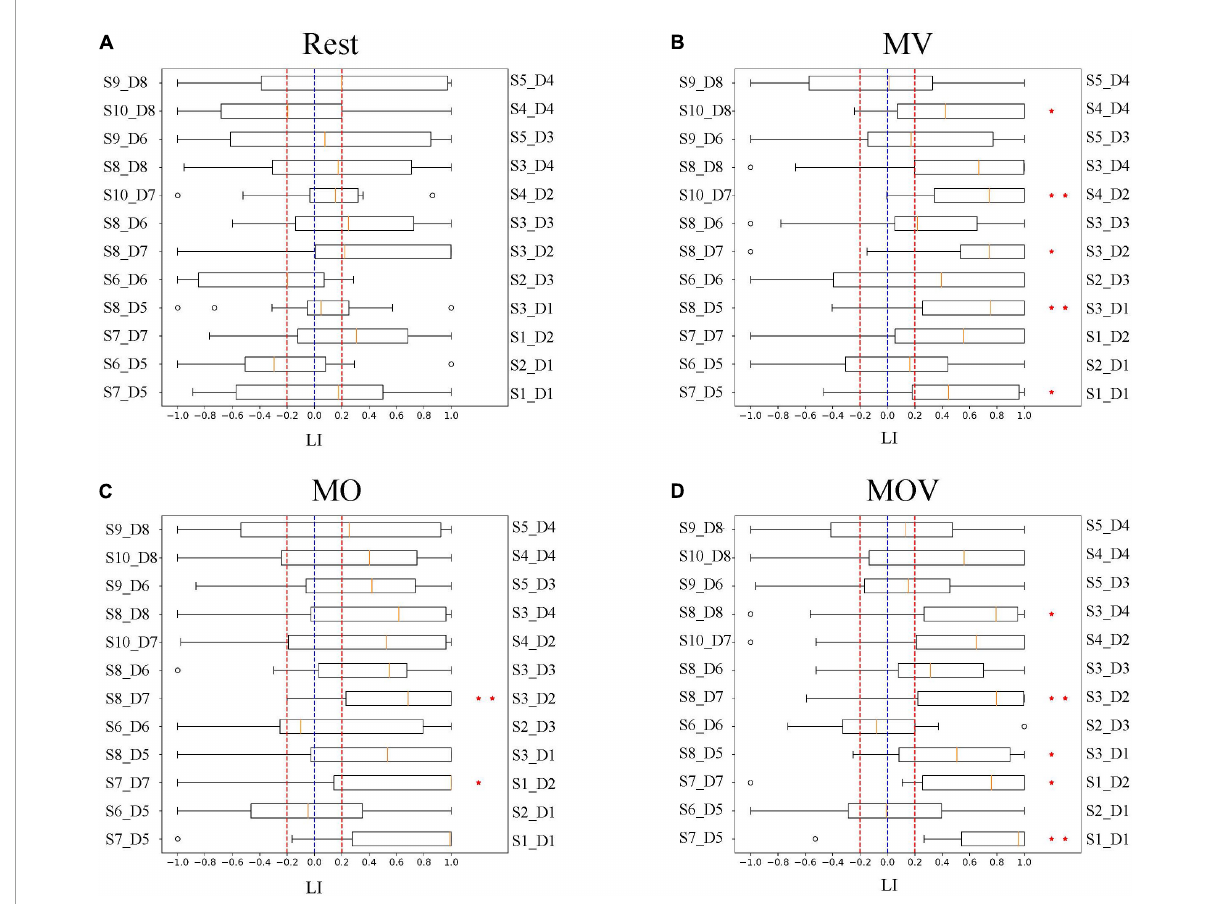
FIGURE8 Cortical lateralization. The subplots (A–D) show the distribution of activation laterality index (LI) for each pair of channel groups under the four task conditions, Rest, MV, MO, and MOV. As shown, the horizontal coordinates of the subplots are the LI, with values ranging from − 1 to 1. The vertical axis indicates the symmetrically located channel groups for 12 channels. Box plots are used to represent the distribution of the LI for 14 subjects under that channel group for that rehabilitation task. They are compared to the threshold of 0.2 for the significance LI at the group level (* indicates p < 0.05, ** indicates p <